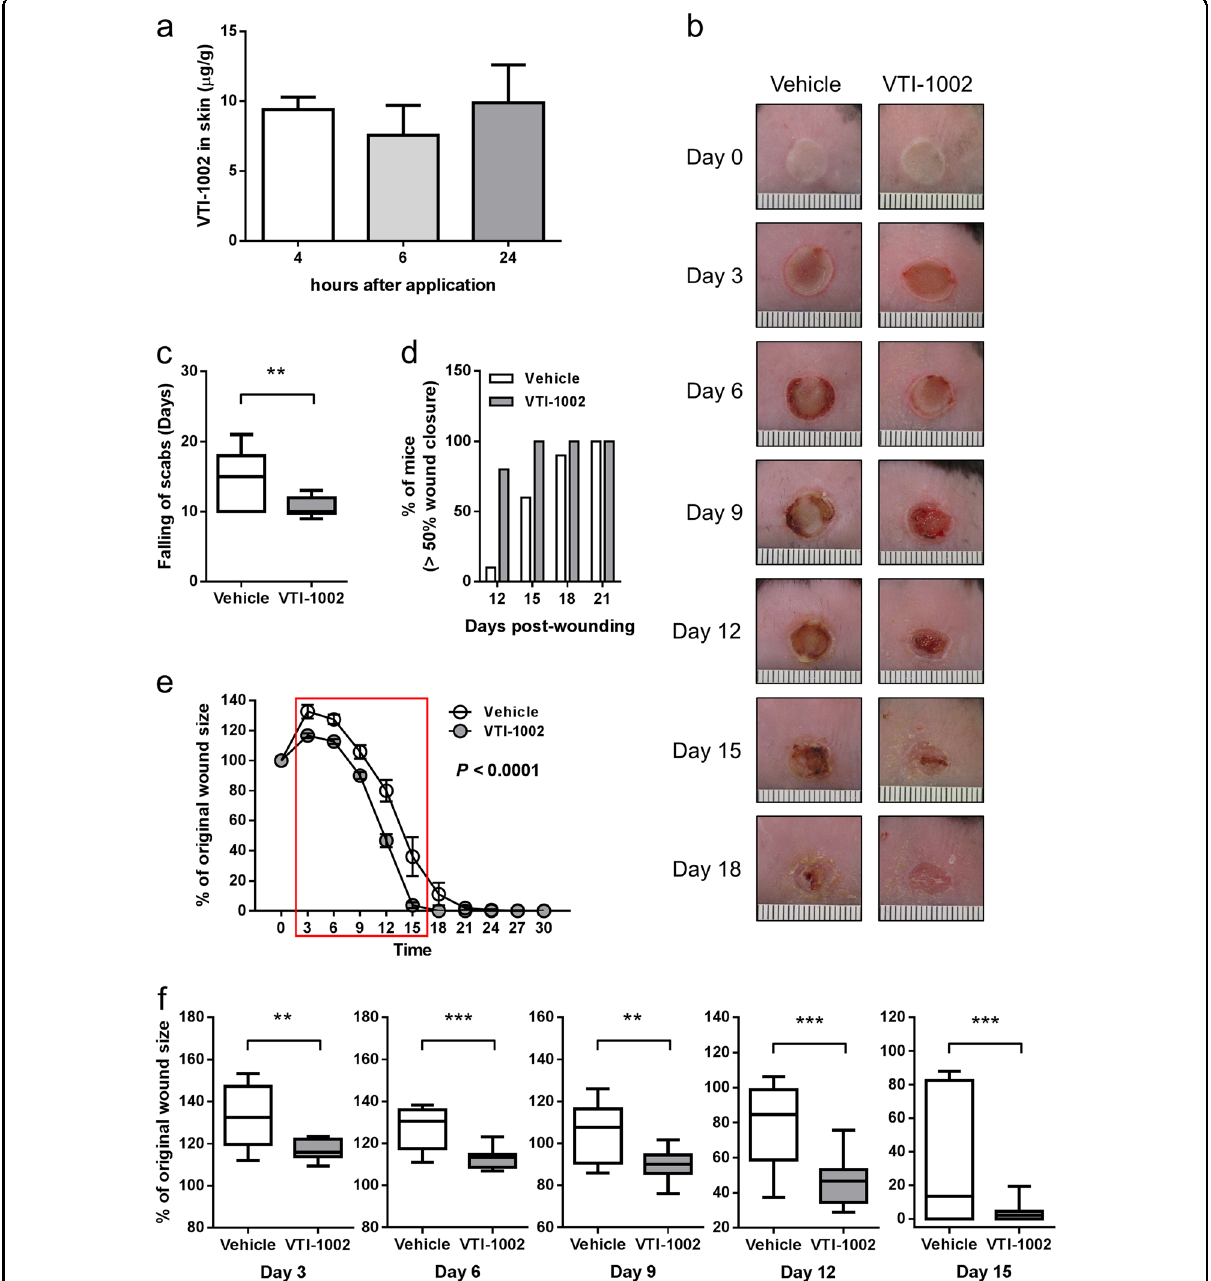
Fig. 1 Topical application of VTI-1002 gel accelerates diabetic burn wound closure. a VTI-1002 is retained in diabetic skin after single topical application. b Representative digital images of diabetic wounds treated with vehicle or VTI-1002 gel captured over fi rst 18 days wound healing period. c Comparison of scab falling-off days between vehicle control group and VTI-1002 treatment group ( n = 10 per group). Results presented in bar graph are expressed as mean ± SEM. Results presented in box-and-whiskers plot are expressed as median and min/max value, ** P < 0.01 by Student's t test. d Percentage of mice achieving over 50% wound closure in vehicle control and VTI-1002 treatment group. e Comparison of wound size over the 30-day healing period between vehicle control group and VTI-1002 treatment group ( n = 10 per group). Results are expressed as mean ± SEM, P < 0.0001 by two-way ANOVA. Red rectangle indicates the window when signi fi cant differences at each day are observed between vehicle control group and VTI-1002 treatment group. f Comparison of wound size at day 3, day 6, day 9, day 12, day 15, and day 18 between vehicle control group and VTI-1002 treatment group ( n = 10 per group). Results are expressed as median and min/max value, * P < 0.05, ** P < 0.01, *** P < 0.001 by Student's t